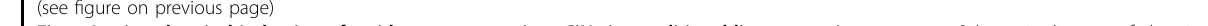
Fig. 1 In vivo chemical induction of resident astrocytes into CiNs in conditional lineage-tracing system. a Schematic diagram of chemical reprogramming in the striatum or cortex of the Aldh1l1-cre mice injected with AAV-FLEX-EGFP. IF, immuno fl uorescence. b Characterization of EGFP + cells in the lineage-tracing mice ( n = 3 mice). c Quanti fi cation of NEUN + /EGFP + cells from 5 brain sections at 45- μ m intervals per mouse in the striatum and cortex, respectively ( n = 3 mice). Quanti fi cation of conversion ef fi ciency of CiNs among EGFP-labeled cells in the striatum and the cortex, respectively ( n = 3 mice). d Immuno fl uorescence analyses showing NEUN + /EGFP + cells in the striatum after chemical treatment was conducted. Cc, corpus callosum. e Immuno fl uorescence analyses showing NEUN + /EGFP + cells in the cortex following chemical treatment. f Schematic representation of the action potential traces and inward currents of CiNs induced in the striatum ( n = 9). g Schematic representation of the action potential traces and inward currents of CiNs induced in the cortex ( n = 3). Scale bars, 200 μ m; 25 μ m in high-magni fi cation panels ( d , e ). Error bars represent SEM. ** P < 0.01, *** P < 0.001 by two-way ANOVA with Sidak ’ s multiple comparisons